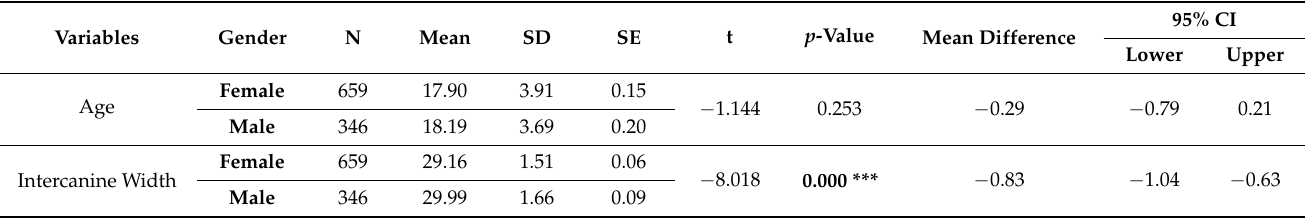
Table 6. Descriptive statistics and comparison of age and arch dimensions between genders (inde- pendent samples t